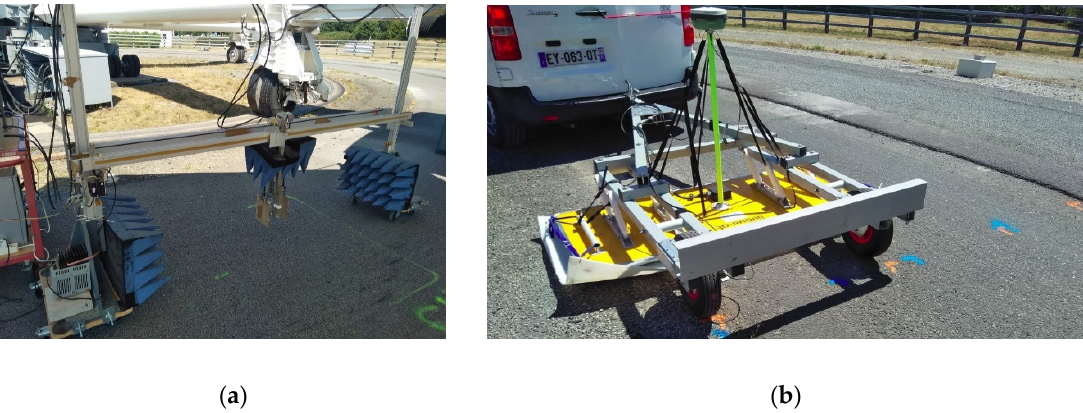
Figure 4. ( a ) Univ. Eiffel’s robotic antenna-holder system associated to the stepped-frequency radar (SFR) with ultra-wide-band (UWB) antennas (surrounding blue cones are electromagnetic (EM) absorbing foams). ( b ) 3D-radar system during acquisition.